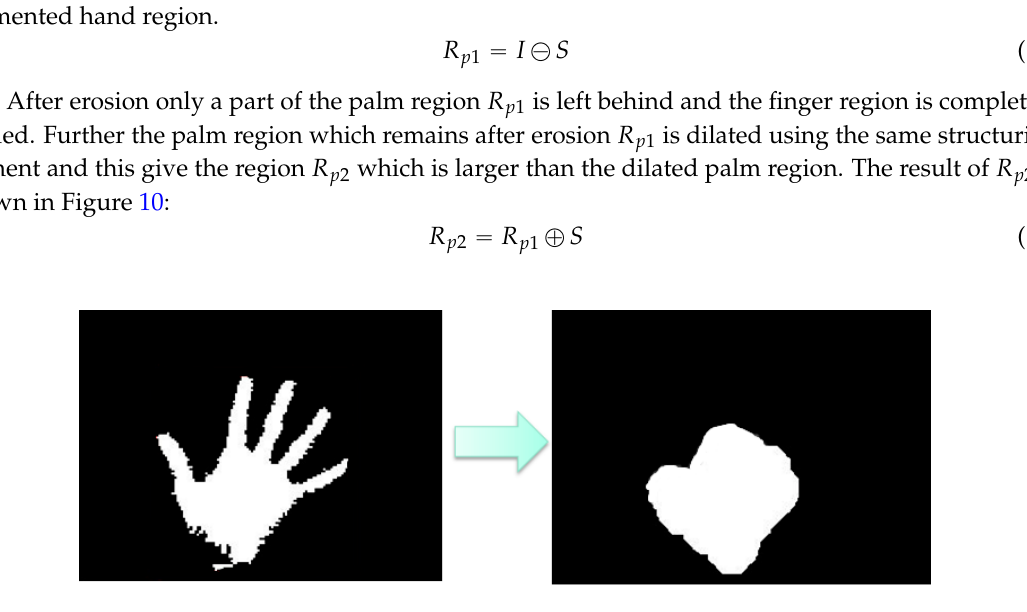
Figure 10. Left image is hand region binary image, the right image is R p 2 .